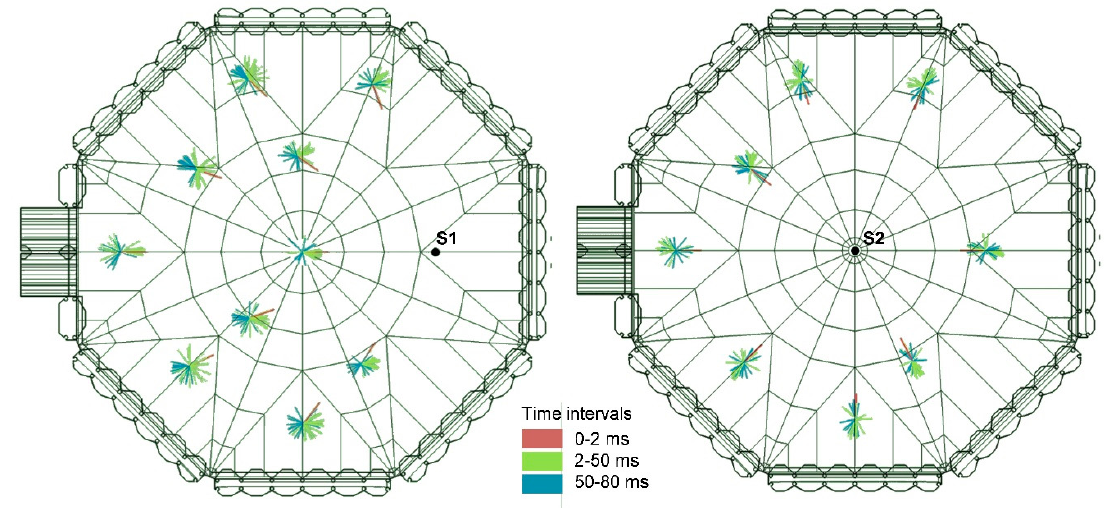
Figure 10. Representation of the early energy arriving at the receiver points (Iris plots, 2D XY plane, level range set to 40 dB with the direct sound level individually set as a reference (0dB)): front stage arrangement (left); and amphitheatre-like arrangement (right).